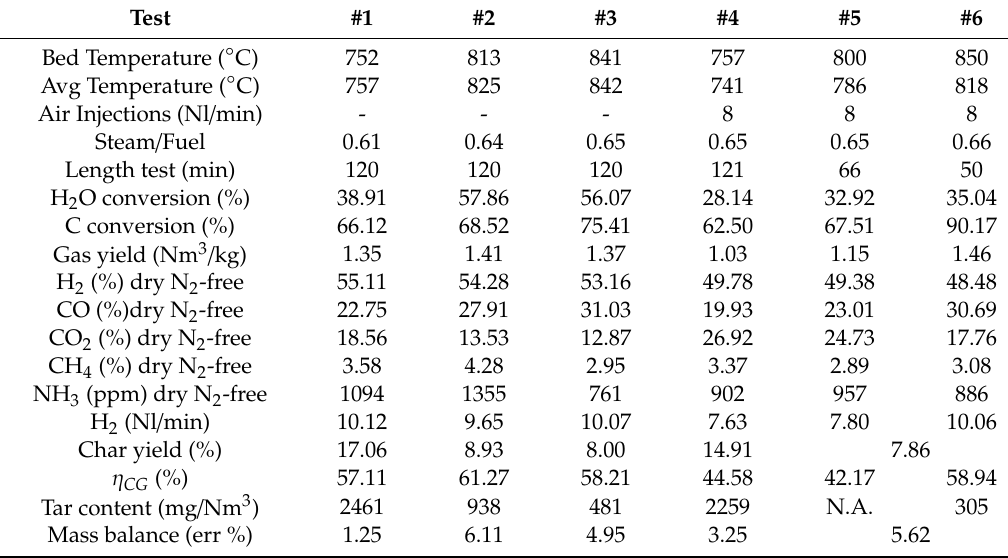
Table 3. Results of lignite gasification tests .